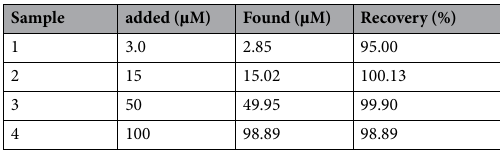
Table 2. Determination of Cd (II) in water samples by MnCo 2 O 4 modified